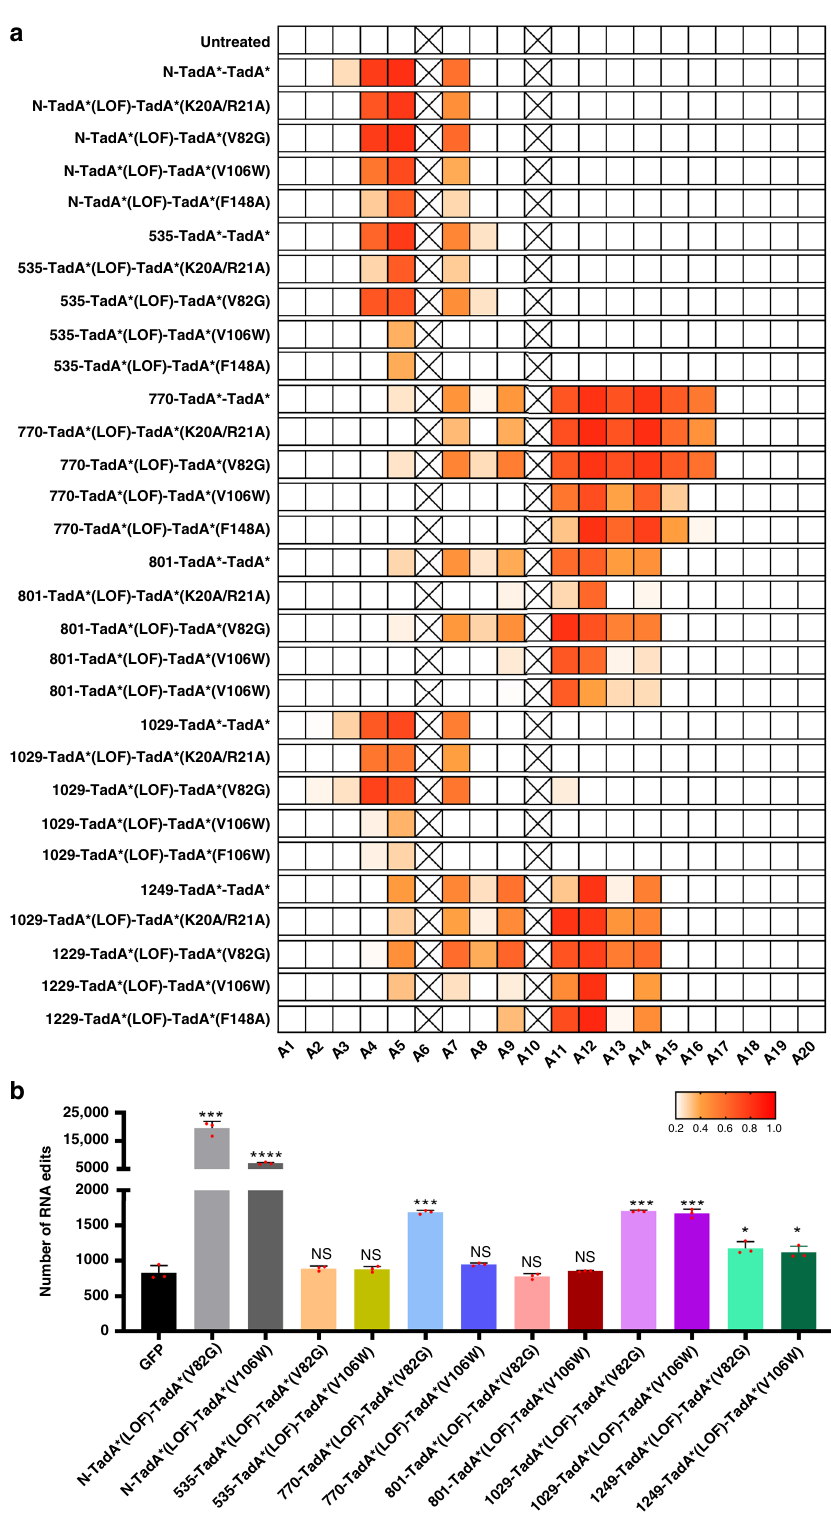
Fig. 4 Comparison of editing scopes and RNA off-target activities for selected ABE-nSpCas9-DS variants. a Base editing activities at each adenine position across four sgRNA sites were averaged and shown in heat map for selected ABE-nSpCas9-DS variants. Boxes with × are positions with no adenine nucleotide at all four sgRNA sites. b Transcriptome analysis showing the number of edited adenine nucleotides in HEK293T cells transfected with selected ABE-nSpCas9-DS variants or N-terminal counterparts and sgRNA-1. Data here are represented as mean with S.E.M. from three biologically independent experiments. Statistical analysis was performed for all experimental groups against GFP group and * p < 0.05, *** p < 0.001; **** p < 0.0001 with two-tailed unpaired t-test. n.s. means no signi fi cance. (from left to right, p = 0.0002; p < 0.0001; p = 0.3825; p = 0.4781; p = 0.0001; p = 0.1230; p = 0.4492; p = 0.7062; p = 0.0001; p = 0.002; p = 0.0110; p = 0.0192;) Source data are available in the Source data fi